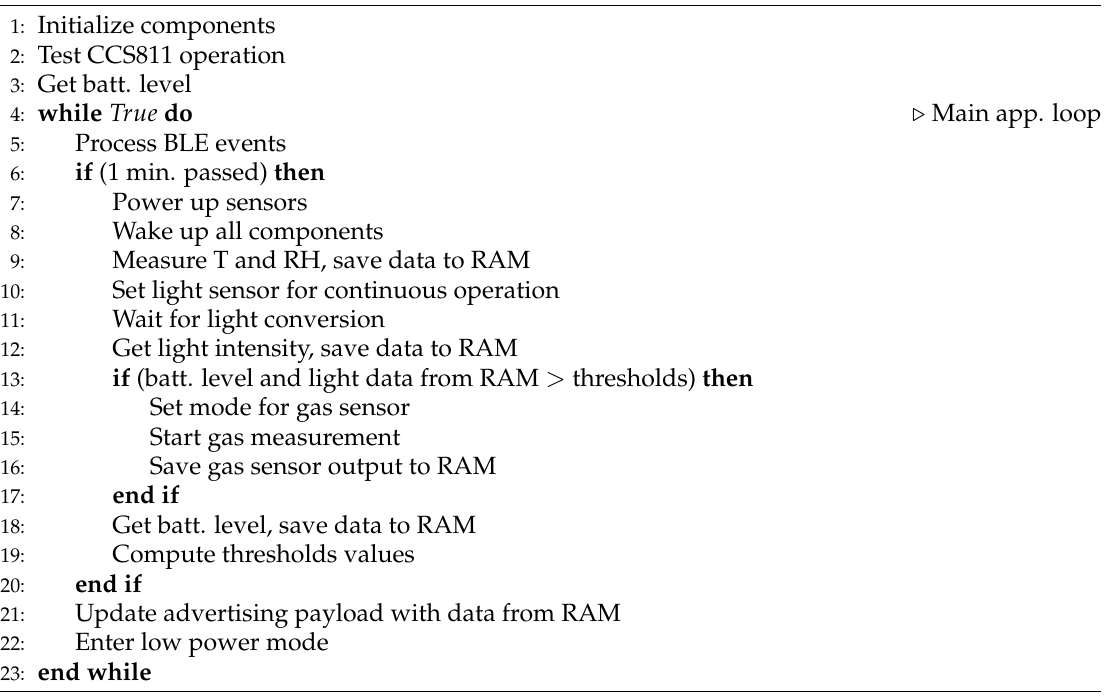
Algorithm 3 Wireless sensor application (T, RH, light intensity, eCO 2 and TVOC)